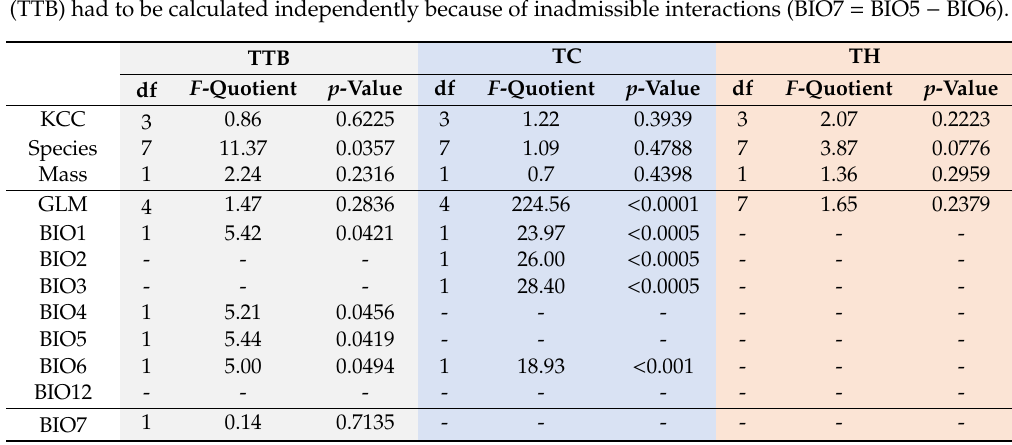
Table 4. Statistical analysis of TTB (thermal tolerance breadth), TC (cold tolerance), and TH